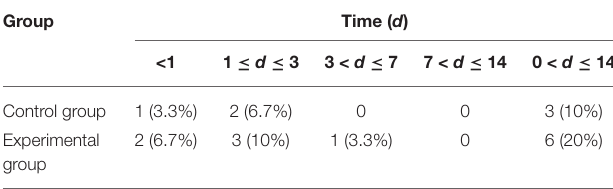
The levels of MMP-9 and TNF- α in serum were measured TABLE 1 | Death records of mice in the two groups after modeling ( n = 30). Group Time ( d )